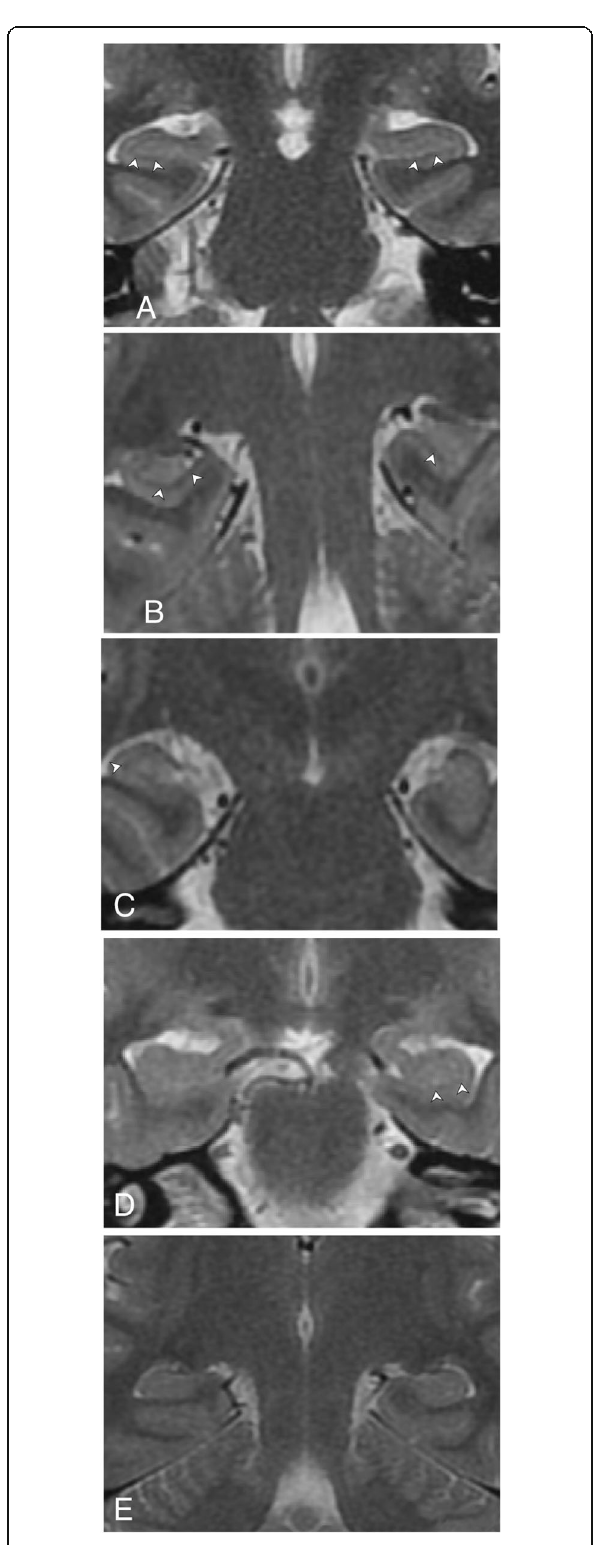
Fig. 1 a – e High-resolution coronal T2-weighted images with magnification. Arrowheads indicate hippocampal striations. a Normal hippocampus: hippocampal striations seen on both right and left sides. Symmetry of semicircular canals can be seen along bottom corners of image on either side. b Left PLHS: hippocampal striation seen better on the right side. On the left side, it is seen only in medial aspect of hippocampus, not in its lateral aspect. c Left PLHS: hippocampal striations seen on the right side, not on the left. d Right PLHS: hippocampal striation seen faintly on the left; not on the right. e Bilateral PLHS: hippocampal striation not well seen on either